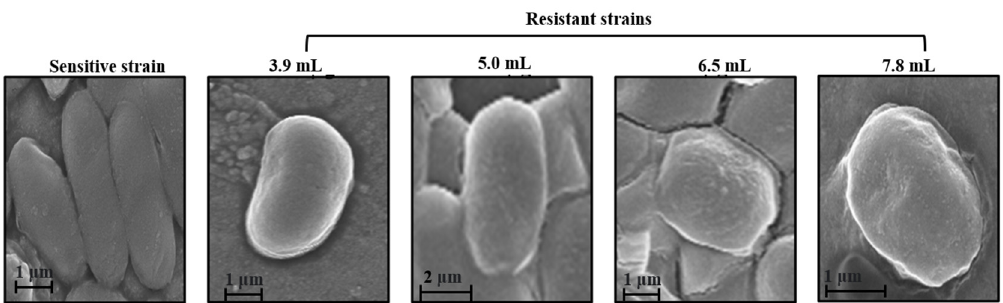
Figure 6. Morphological changes associated with induction of colistin resistance (3.9, 5.0, 6.5, and 7.8 ug/mL) analyzed using